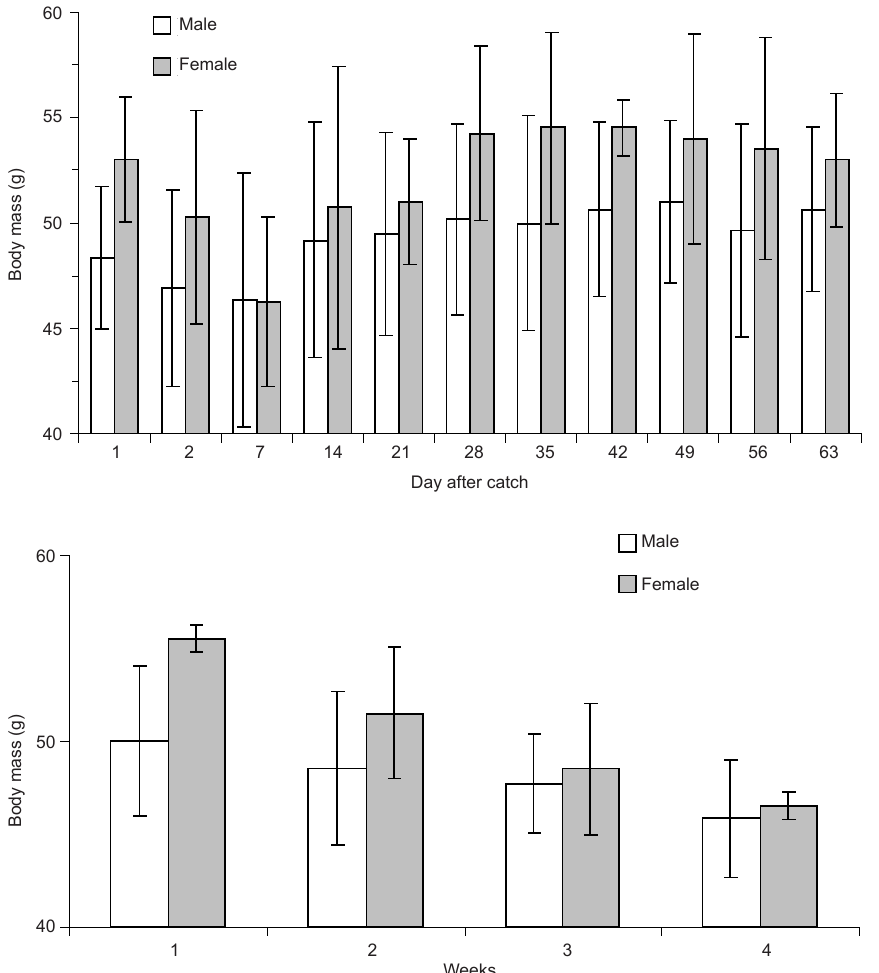
Figure 4a, b. Change in average body mass of C. sphinx : a). (n = 15) over a period of 63 days in a flight cage, b). (n = 6) over a period of four weeks in a small